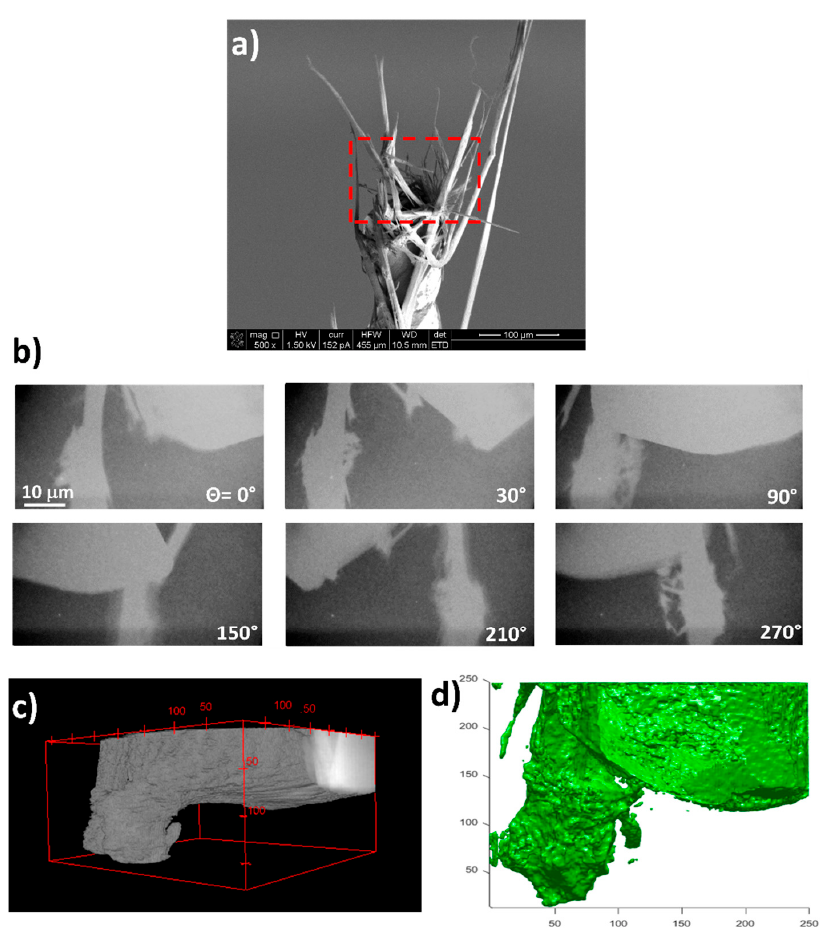
Figure 23. ( a ) SEM image of the caffeine crystals, on the top of the tip-sample holder. ( b ) Shows some of the projections acquired in SXR, at different angles. ( c ) Three-dimensional (3D) reconstruction of the reconstructed image of the crystallized caffeine (electron density surface) obtained using the ImageJ software [93,94]. ( d ) Crystals reconstruction using the total iterative constraint strategy. Figure modified, based on [59].